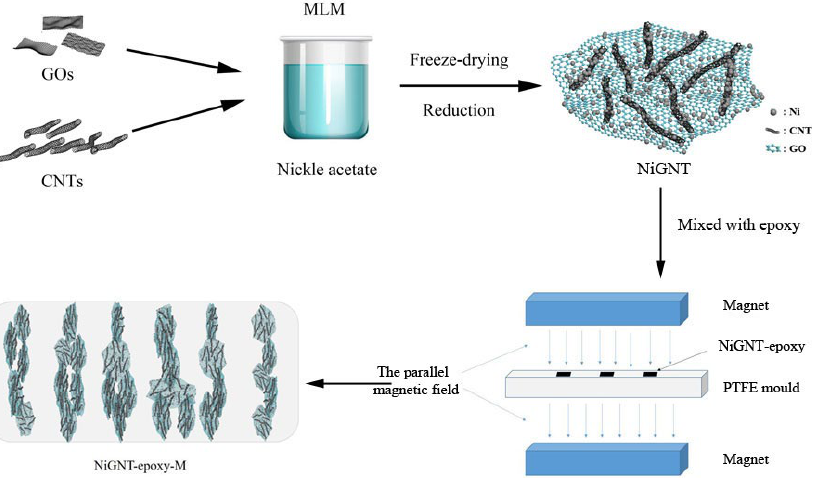
Figure 1. Schematic of the preparation of NiGNT nanostructures and the alignment of NiGNT– epoxy composites.